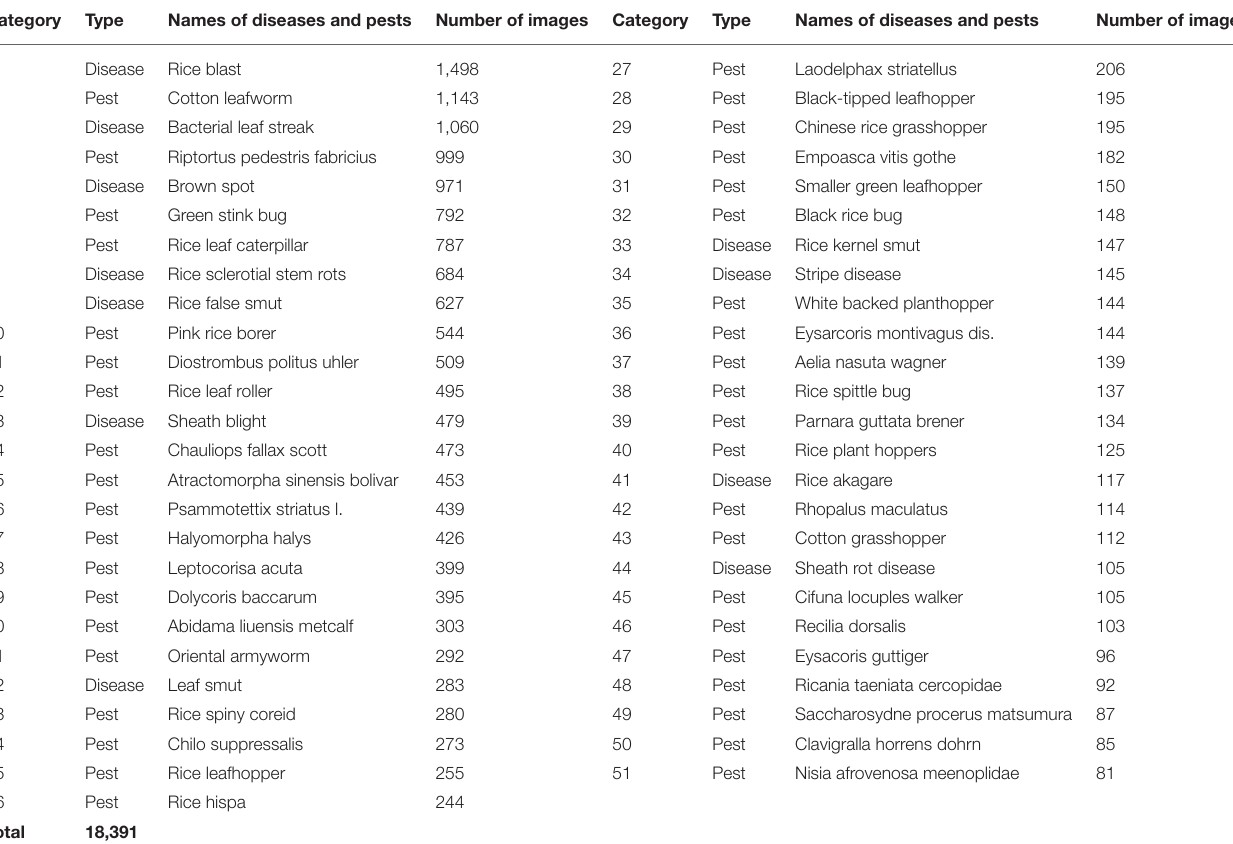
TABLE 1 | RPDID dataset of rice pest and disease images collected in the field. Category